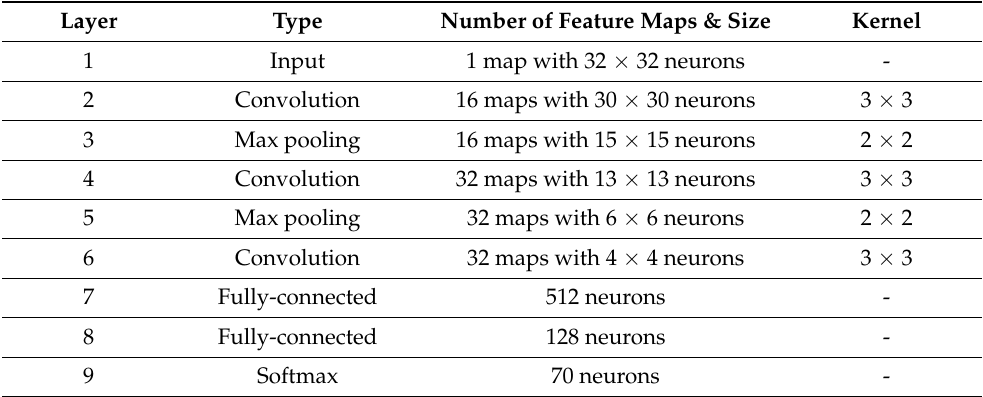
Table 2. The structure of the character recognition model.